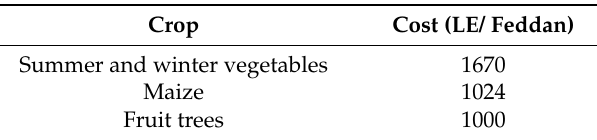
Table 14. Production cost by crop.